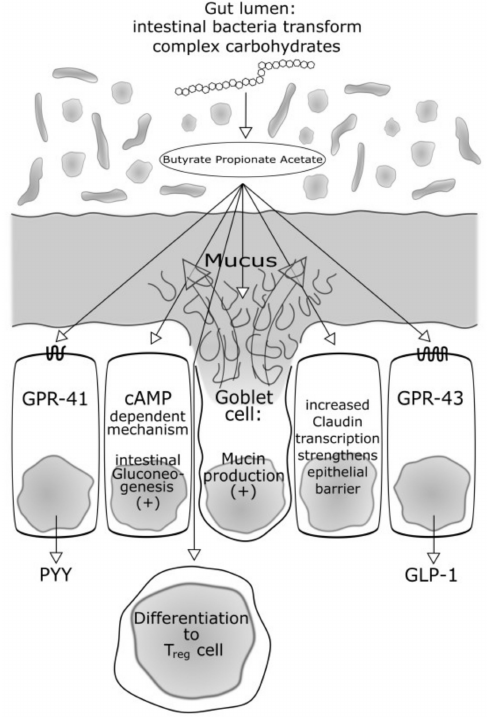
Figure 1. Some of the yet studied effects of short-chain fatty acids (SCFAs): (1) Peptide YY is expressed after SCFA-dependent activation via the G-Protein coupled 41 receptor (GPR-41); (2) Glucagon-like Peptide 1 (GPR-1) is expressed after SCFA-dependent activation via the G-Protein coupled 43 receptor (GPR-43). Glucagon-like Peptide 1 (GLP-1) and PYY inhibit gut motility, reduce appetite and reduce energy harvest; (3) Propionate and Butyrate activate the intestinal gluconeogenesis (IGN) via complementary mechanisms. Butyrate activates an IGN gene expression through a cAMP-dependent mechanism. Propionate, itself a substrate of IGN, activates IGN gene expression via a gut-brain neural circuit involving the fatty acid receptor FFAR3; (4) SCFA promote the formation of peripheral regulatory T cells from naive CD 4+ Cells. It is speculated that SCFAs, especially Butyrate, are inhibitors of some histone deacetylases. An acetylation of Histone 3 promotes the expression of the T regulatory (reg) specific transcription factor Fox P3; (5) Intestinal mucin synthesis. In cultures of human goblet cell-like LS174T cells, Butyrate, as well as propionate, induce an increase in MUC2 mRNA levels; (6) Protective effects of butyrate for the endothelial barrier. Butyrate decreases the molecular permeability of the intestinal barrier. Butyrate acts through increasing Claudin-1 transcription by facilitating the association between SP1 (transcription factor) and the Claudin-1